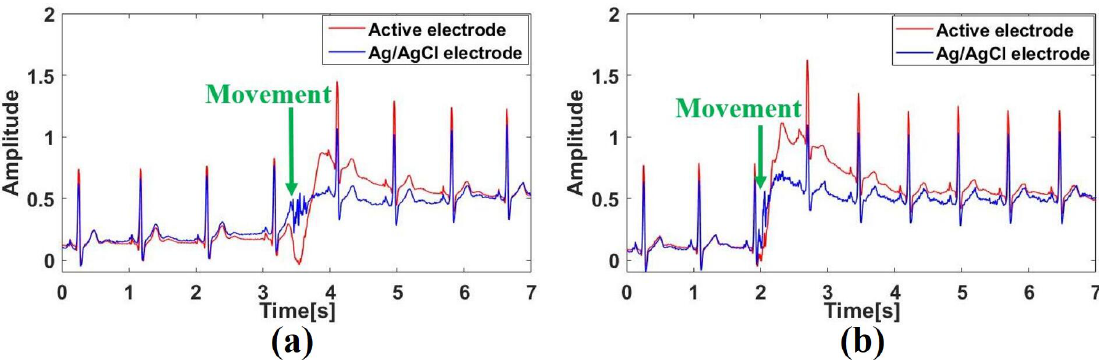
Figure 8. ECG measurement under turning movement of upper body: ( a ) left turning movement of upper body, ( b ) right turning movement of upper